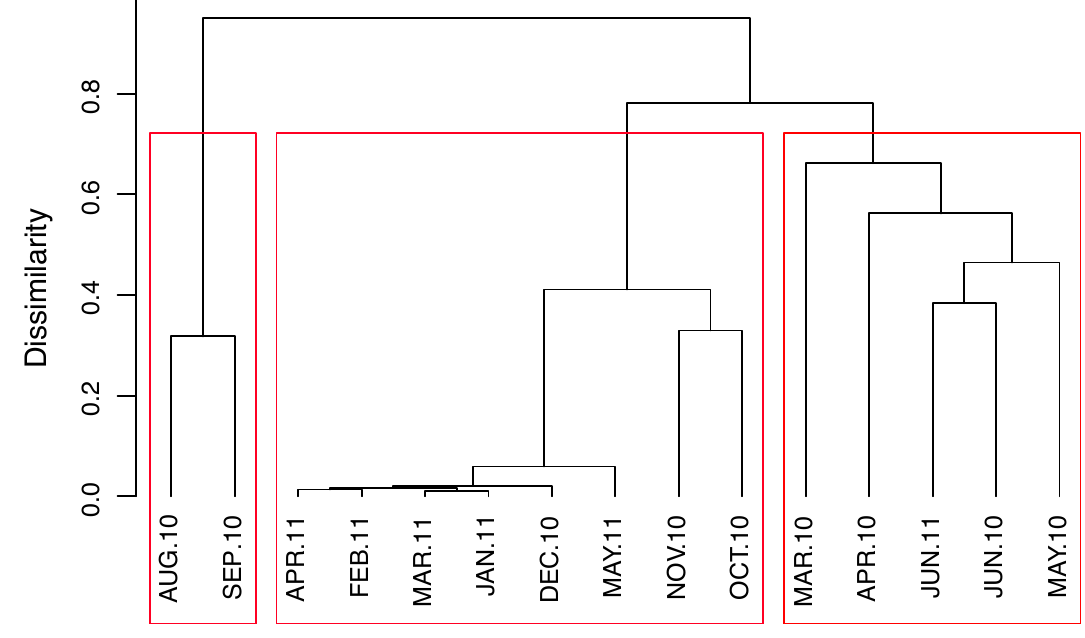
Figure3. BrayclusteringanalysesrepresentingBray–Curtissimilaritiesinviruscommunitycomposition based on vOTU